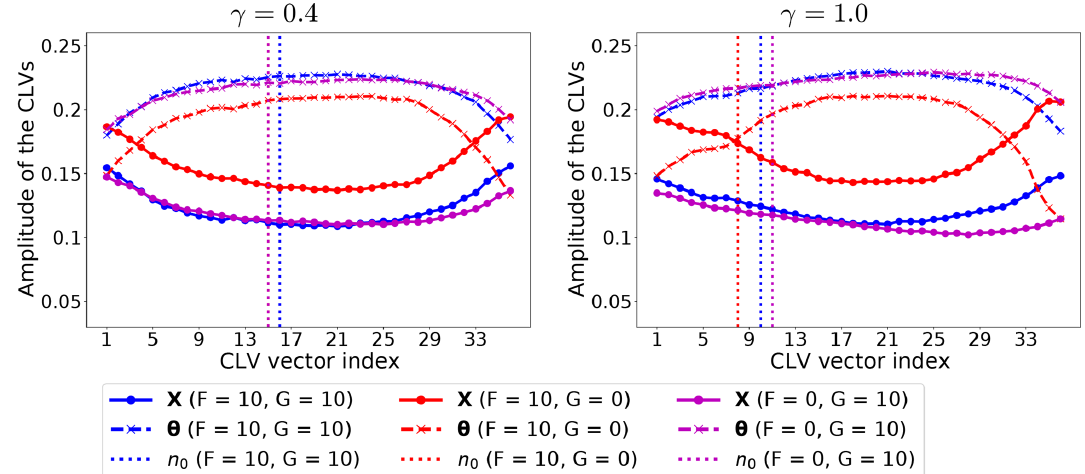
Figure 6. Normalized time-averaged amplitude of CLV components for γ = 0 . 4 and γ = 1 with α = 1. The vertical lines indicate the dimension of the unstable–neutral